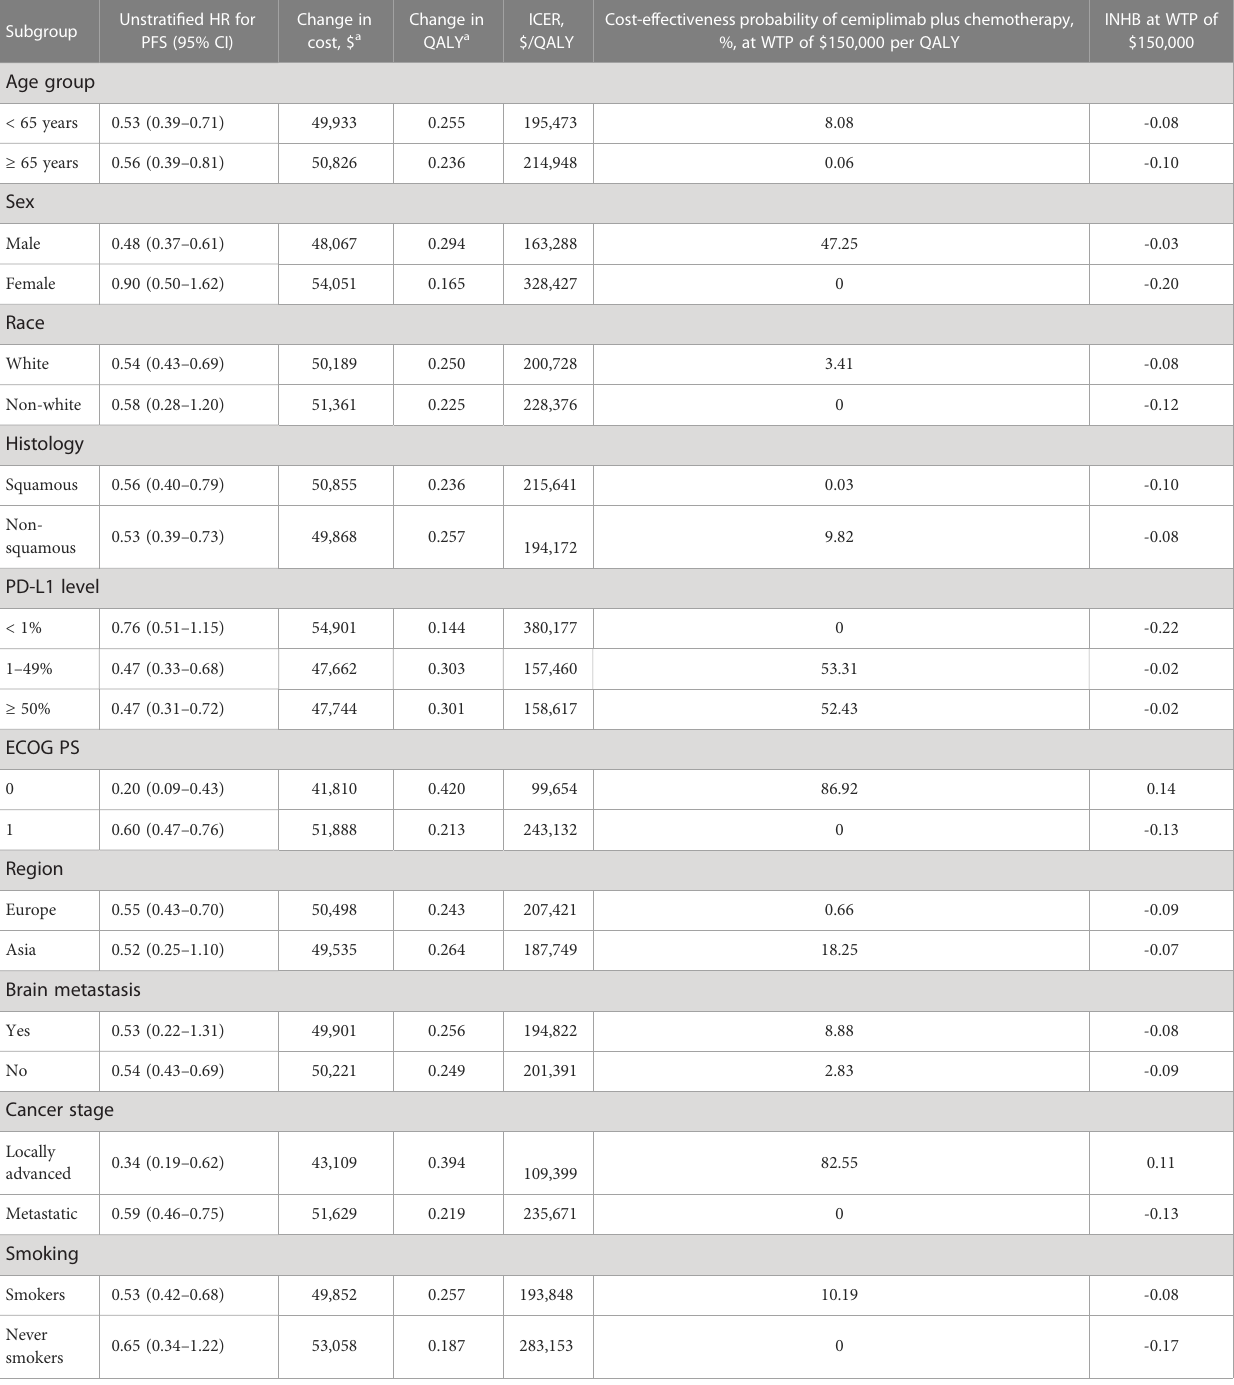
TABLE 4 Summary of subgroup analysis obtained by varying the hazard ratios (HRs) for progression-free survival.